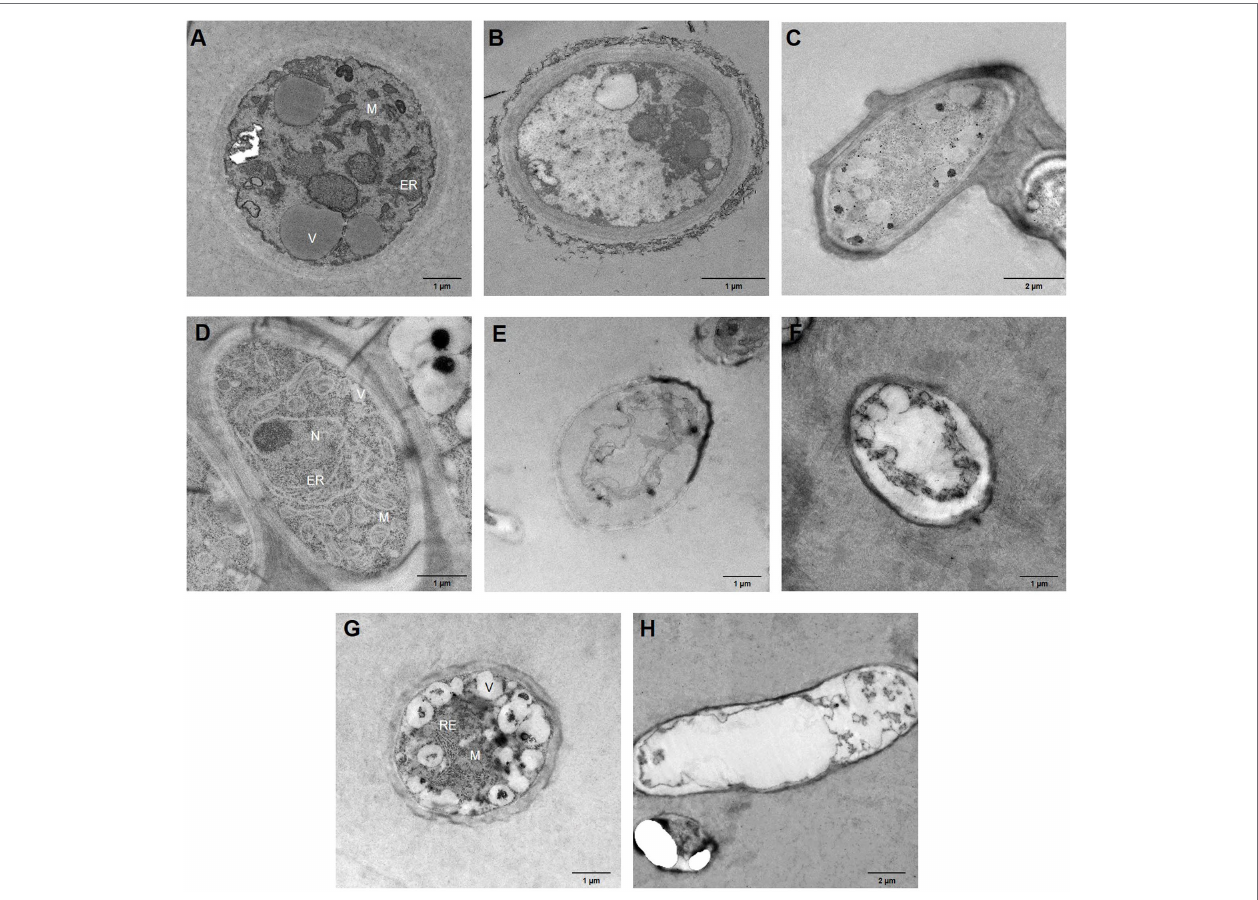
FIGURE 4 | Transmission electron micrographs of fungal hyphae after 7 days of bacterial VOC treatment. (A) Untreated B. cinerea . (B) B. cinerea – B. velezensis XT1 strain. (C) B. cinerea – B. atrophaeus L193 strain. (D) Untreated M. laxa . (E) M. laxa – B. velezensis XT1 strain. (F) M. laxa – B. atrophaeus L193 strain. (G) Untreated M. fructicola . (H) M. fructicola – P. vulpis Z8 strain. ER, endoplasmic reticulum; M, mitochondria; N, nucleus; and V,